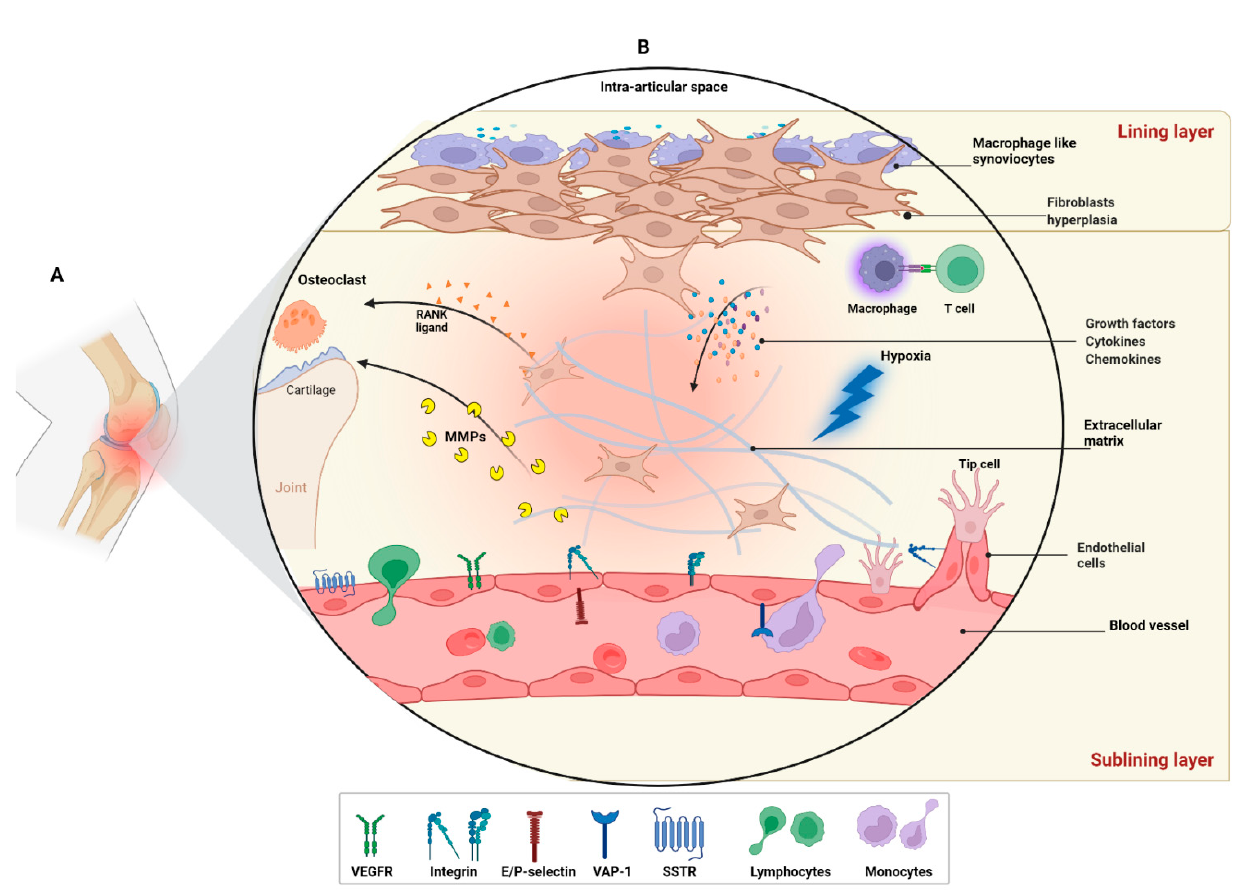
Figure 1. ( A ) Schematic view of an inflamed arthritic knee. ( B ) Detailed viewed of the inflamed RA synovium, particularly highlighting processes involved in